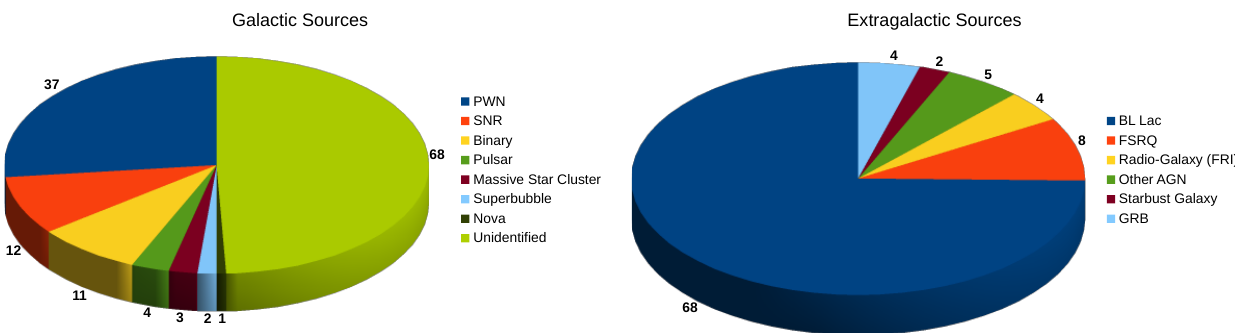
Figure 17. Population of established VHE sources extracted from the TeVCat [48] meta-catalogue. ( Left ) Galactic sources. ( Right ) Extragalactic